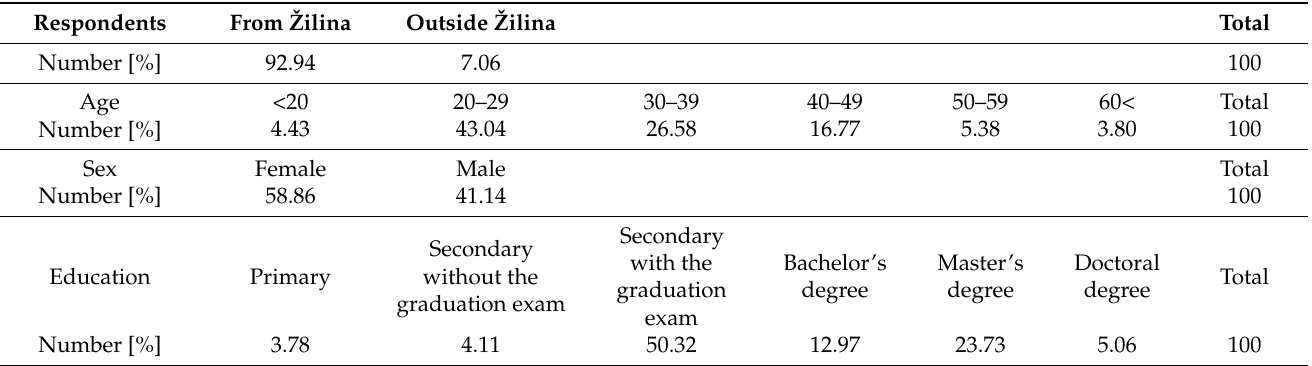
Table 4. Results of sorting